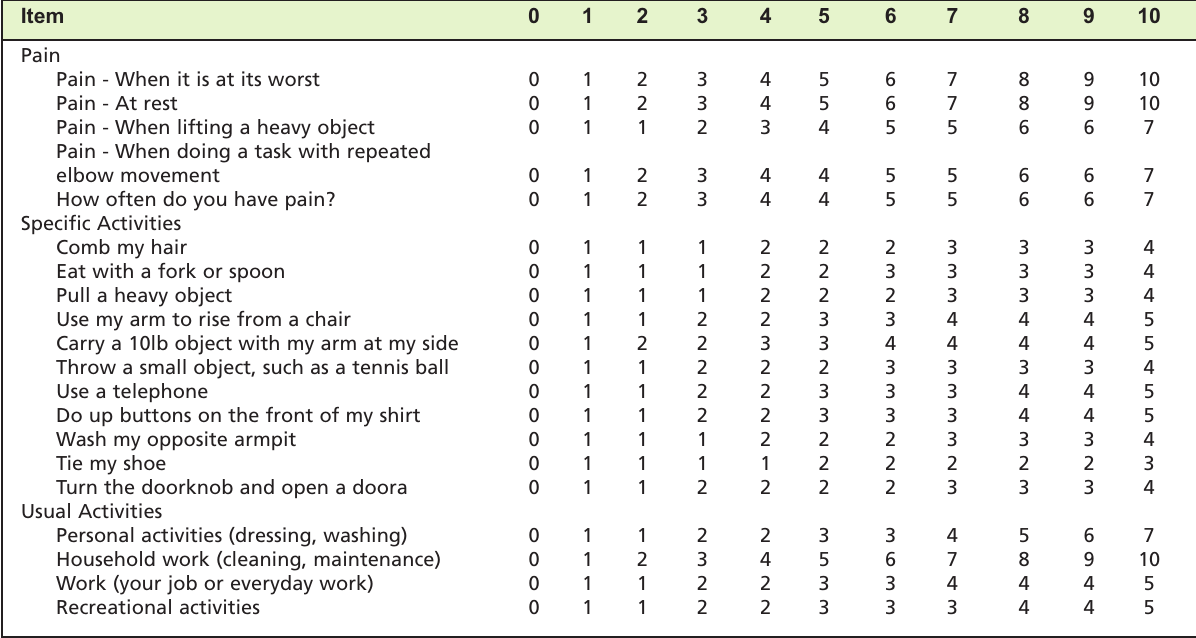
PRTEE – patient rated tennis elbow evaluation Table III: